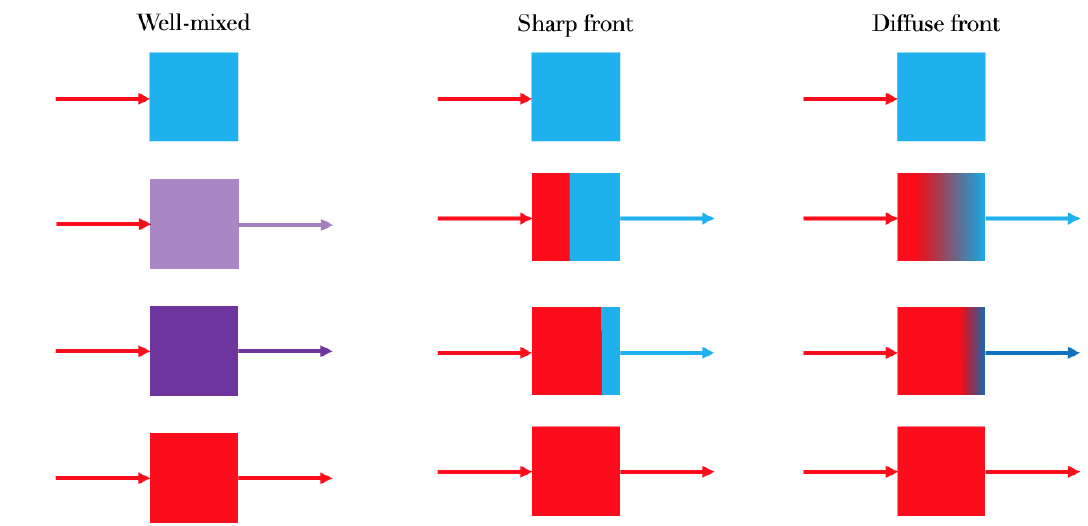
Figure 1. TES system thermal front conceptualization. Well-mixed is the worst scenario, which leads to a large waste of thermal energy. Sharp front is an ideal method with minimal thermal energy loss. Diffuse front is the practical scenario with thermal